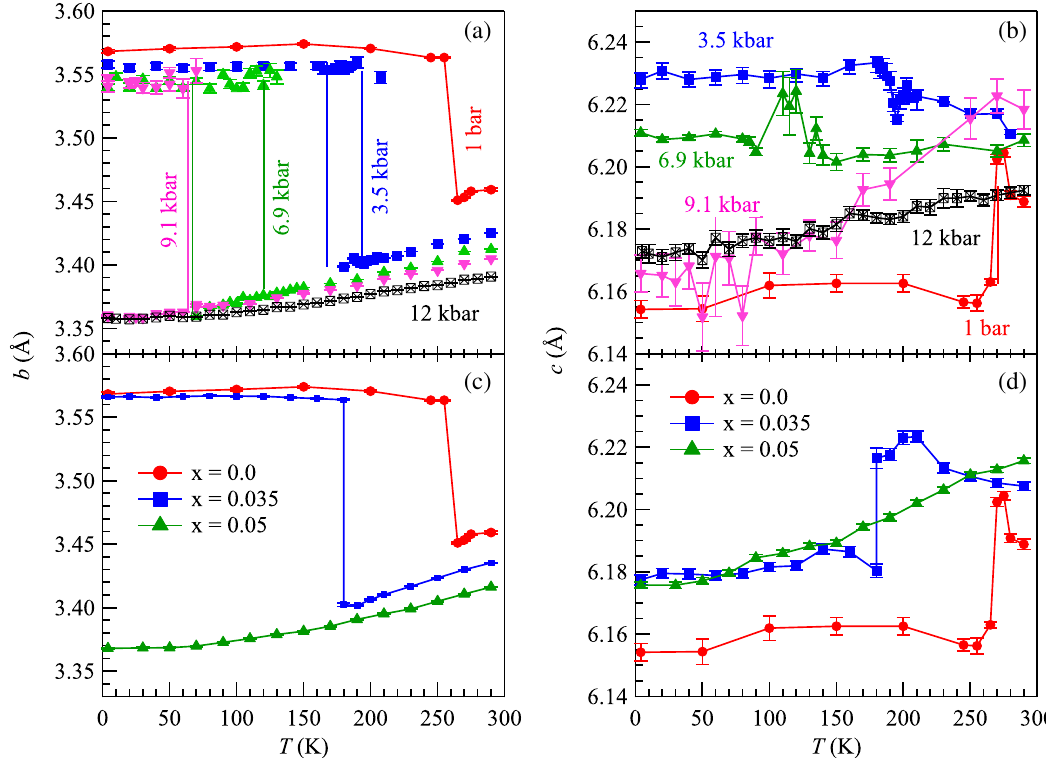
FIG. 1. Temperature dependence of the lattice constants b and c for CrAs under (a),(b) external pressures up to 12 kbar and (c),(d) chemical pressure via P substitution for As in CrAs 1 − P ( x ¼ 0 , 0.035, 0.05). These data were obtained during the cooling process, in x x which the temperature ranges marked by the two solid lines in (a) represent the two-phase coexistence